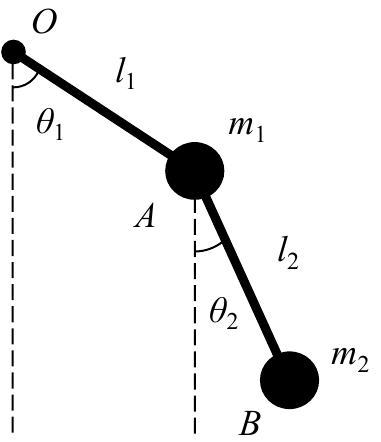
Figure 15. Primary structure of double pendulum.